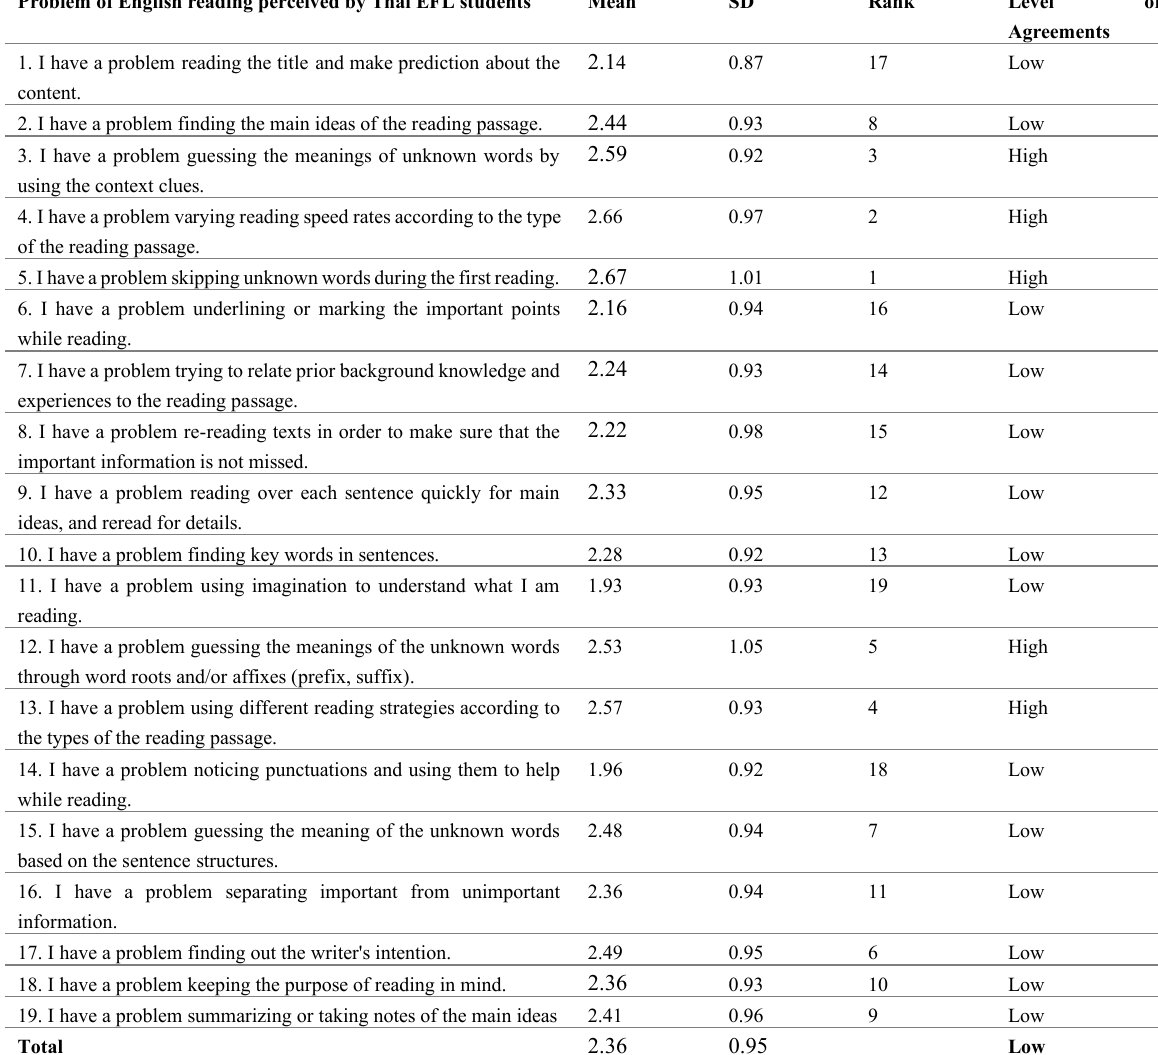
Table 4: Problems of using English reading strategies perceived by Thai EFL students Problem of English reading perceived by Thai EFL